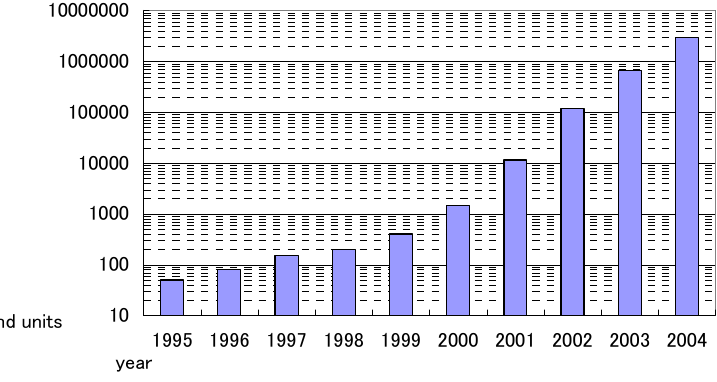
Figure 12. Writable DVD media